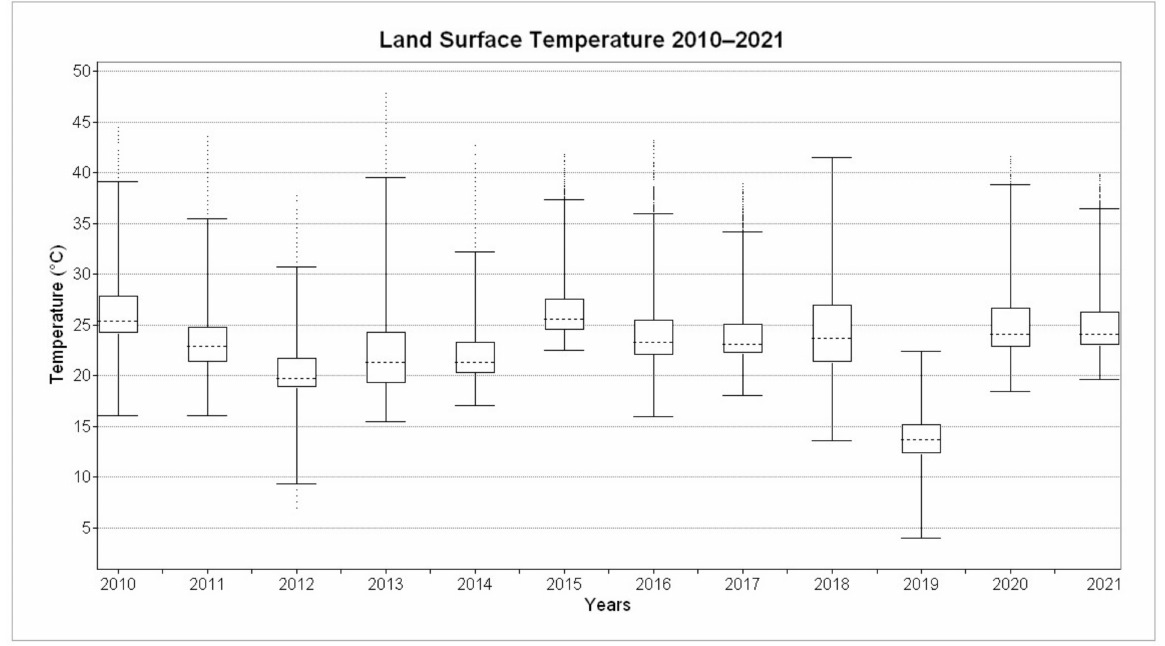
Figure 4. Distribution comparison of LST calculated from Landsat images for evaluated days (Table 1) in 2010–2021. Boxes indicate median and quartiles, and whiskers extend to the most extreme data points, not considering outliers (defined by 1.5 interquartile